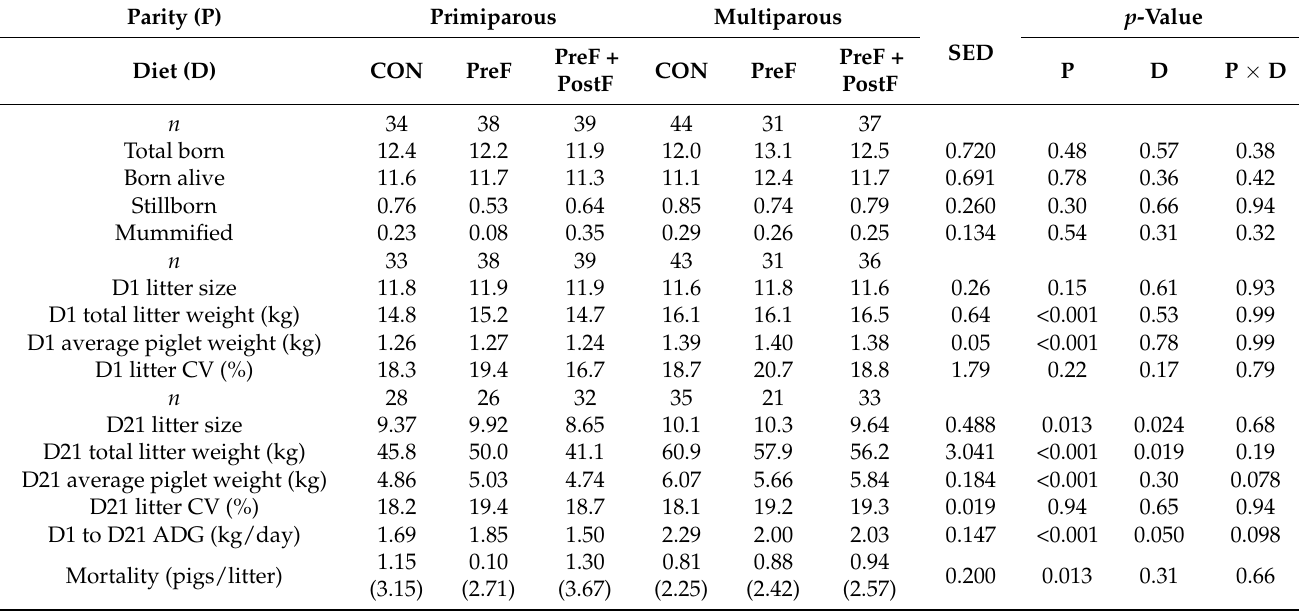
Table 4. Litter performance of primiparous and sows fed either a commercial control diet (CON) or the SIMLUC 2 diet fed either pre-farrowing (PreF) or pre- and 10 days post-farrowing (PreF + PostF). Parity (P) Primiparous Multiparous